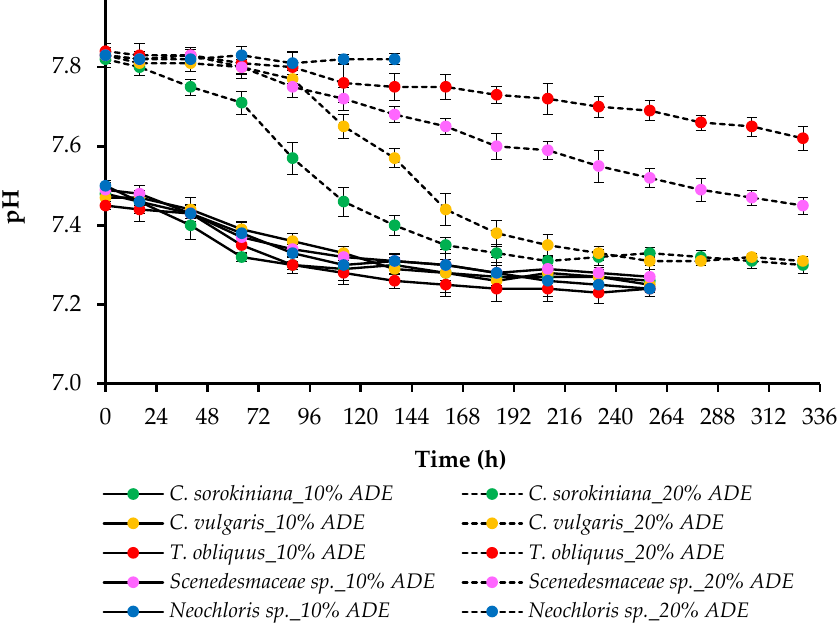
Figure 6. pH changes during the growth of microalgae in 10% ADE and 20% ADE. The current study evaluated the removal of NH 4+ -N from ADE-based culture media by algae. After 136 h of cultivation, all strains achieved 100% nitrogen removal in 10% ADE. The highest NH 4+ -N removal rate in 20% ADE was achieved during cultivation of C. sorokiniana EZ ‐ 07, while the efficiency of other strains decreased as the concentration of ADE increased. In harsh environmental conditions, only tested Chlorella strains were able to sustain growth and consume all available ammonium.